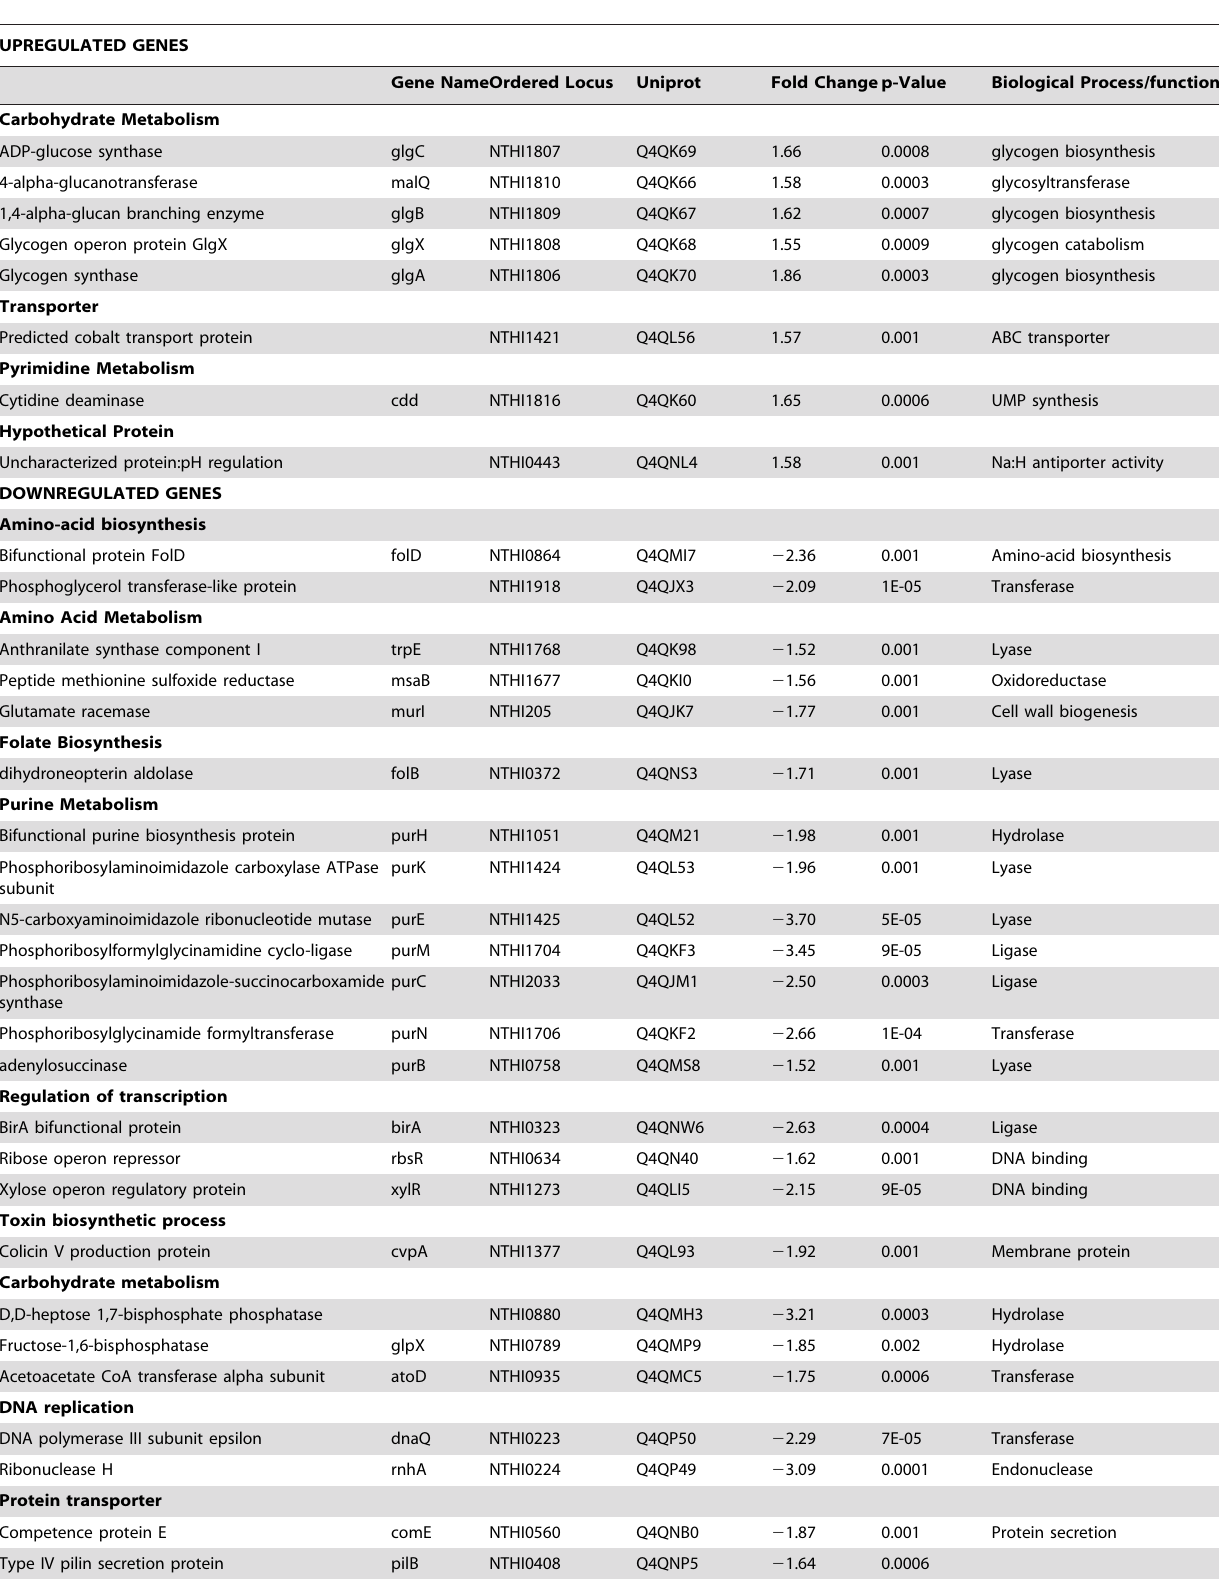
Table 1. Significant genes identified by microarray transcriptomic analysis in the biofilm bacteria exposed to 170 ng/mL ampicillin.